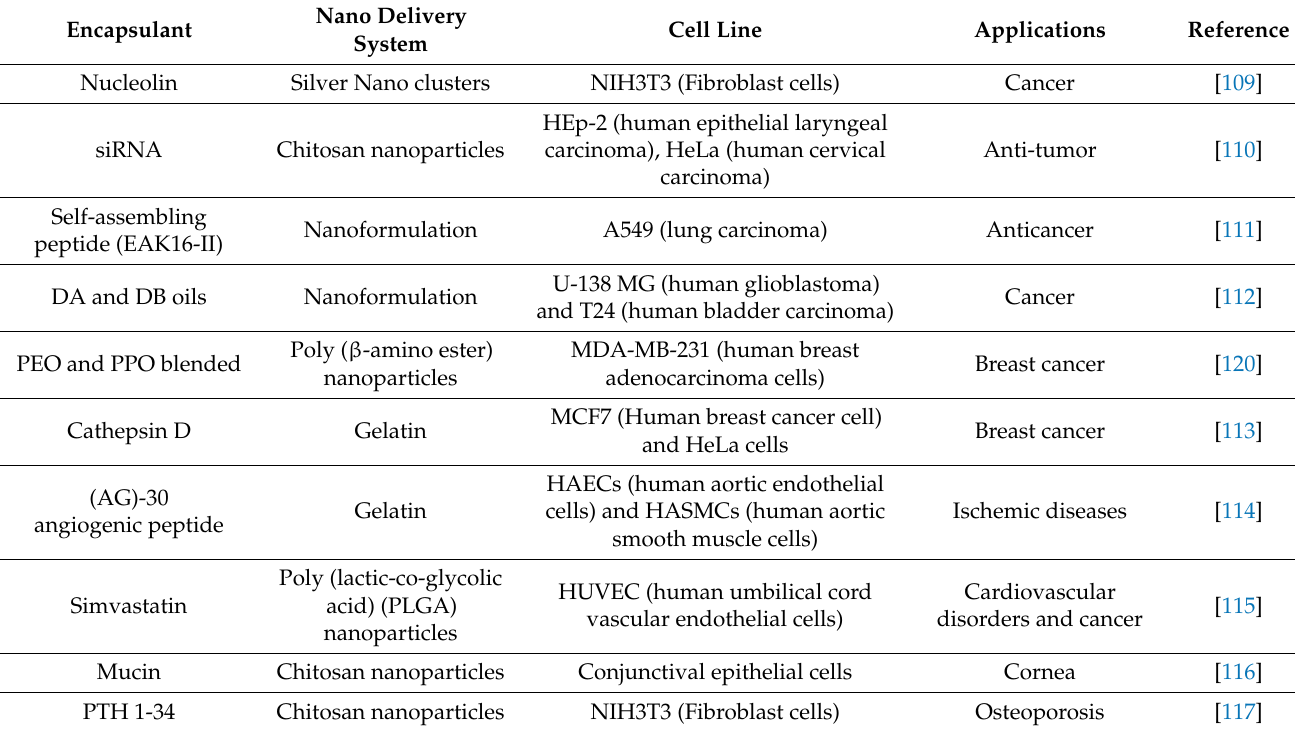
Table 3. In vitro analysis to evaluate the efficacy of nanoformulated